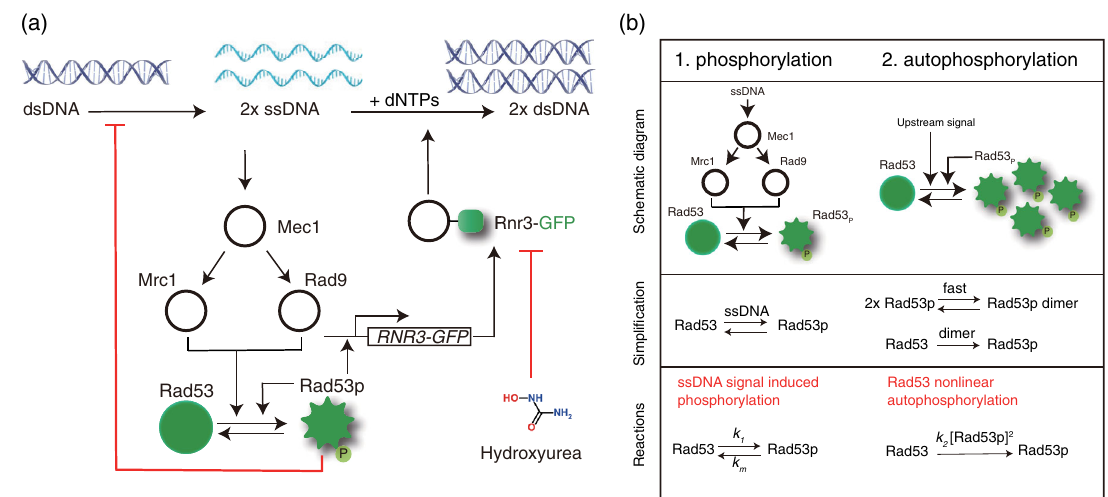
FIG. 7. (a) Schematic diagram for the chemical reactions in Rad53 phosphorylation in the S-phase checkpoint pathway. (b) Two main processes of Rad53 phosphorylation. The left column denotes the phosphorylation induced by the upstream signal, and the right column denotes the autophosphorylation of